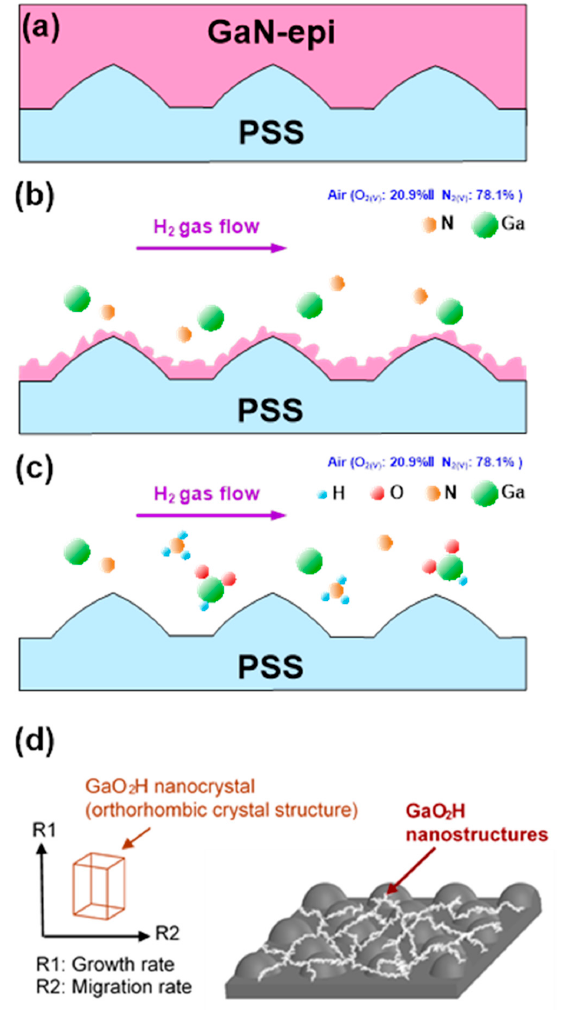
Figure 7. Schematic diagram for ( a ) a GaN-epi/PSS structure, ( b ) the H 2 chemically reacted with GaN, releasing nitrogen atoms and leaving the Ga atoms, ( c ) Some of the Ga atoms reacted chemically with the O atoms in the air and the loading gas H 2 , forming GaO 2 H nanocrystals. Meanwhile, some of the N atoms reacted with H 2 to produce NH 3 , and ( d ) the remaining GaO 2 H nanocrystals were formed a discontinuous and uneven GaO 2 H nanostructure on the exposed PSS